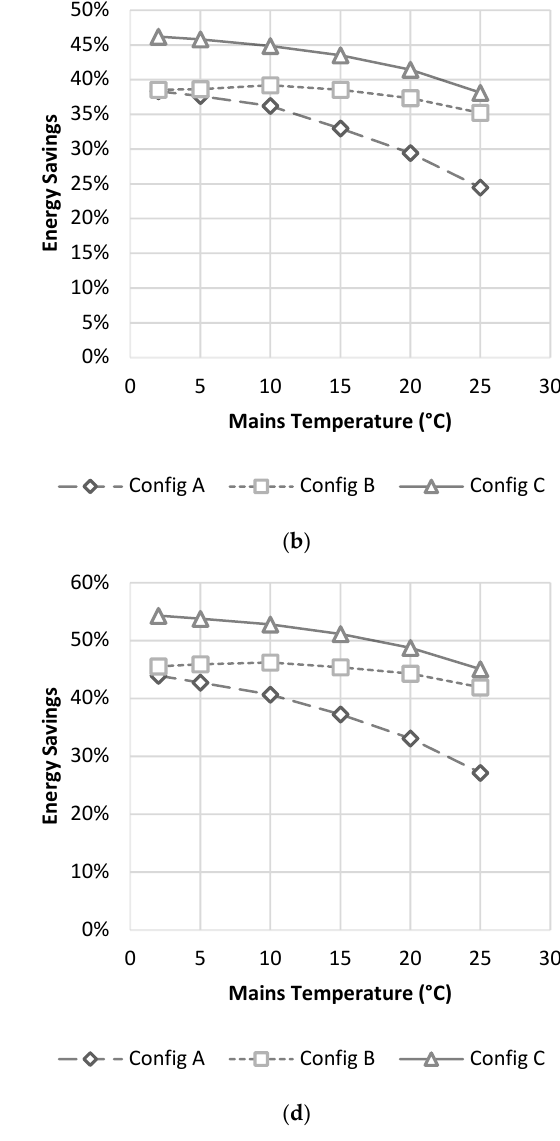
Figure 4. Energy savings as a function of mains temperature for a showerhead flowrate of 5.5 L/min for configurations A, B and C, as labelled. The plots correspond to heat exchanger 1 ( a ), heat exchanger 2 ( b ), heat exchanger 3 ( c ), and heat exchanger 4 ( d ). . m is the mass flow rate In this equation, C represents the heat capacity rate (kW/ ◦ C), (kg/s), and Cp is the specific heat (kJ/kg ◦ C). Equation (3) is often used in the ε -NTU method for heat exchanger analysis. For this study, constant properties were used, so Equation (3) can be reduced to a ratio of mass flowrates. Note that the maximum flowrate in this study always corresponds to the flowrate of water at the showerhead fixture, which is equal to the flowrate through the drain side of the heat exchanger. The minimum flowrate corresponds . . m coils and m drain . The heat capacity ratio, C r , is nondimensionalized, and to the lower of is bound between 0 and 1. When the flowrates through the coils and drain are equal . m coils (i.e., Config C), C r will be equal to 1; however, for the other two configurations,